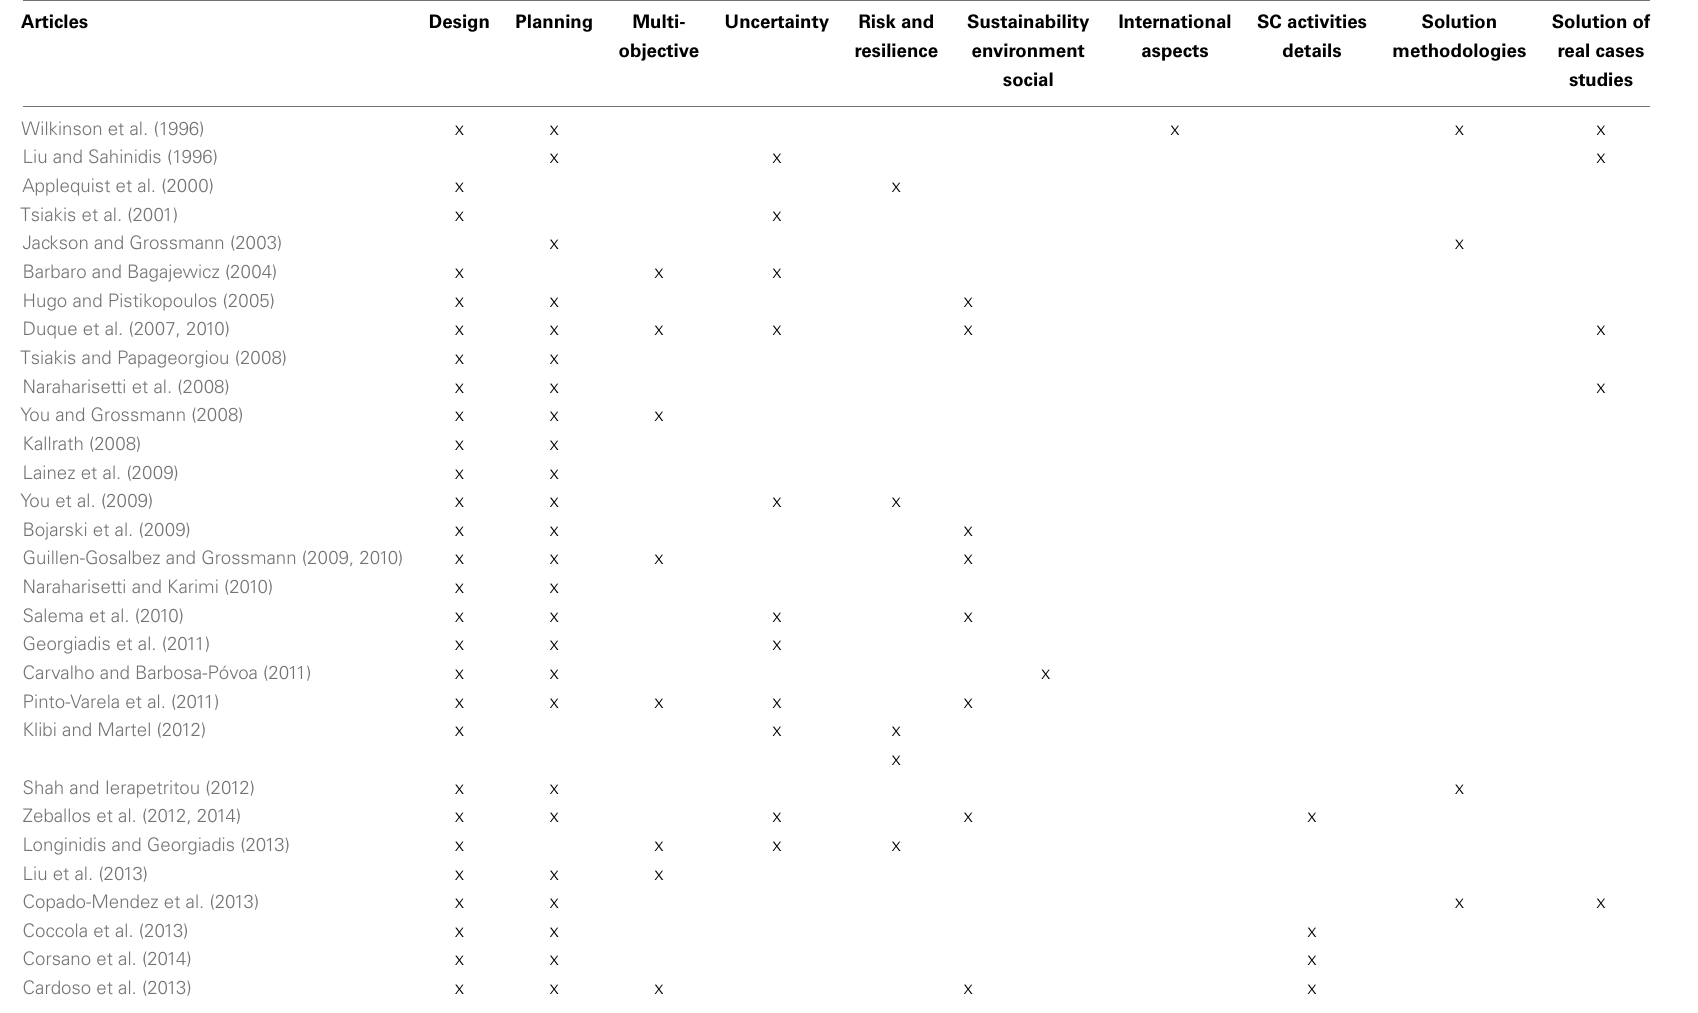
Table 2 | Main contributions on supply chain design and planning .